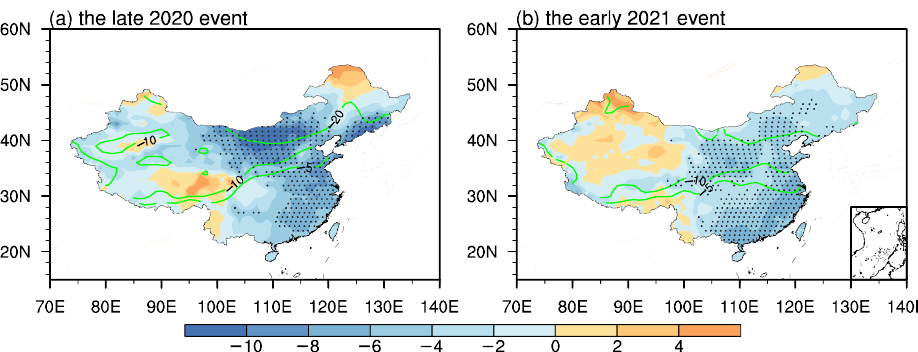
Figure 1. Average temperature drop (shading, unit: °C) in the late 2020 event and the early 2021 event. The average temperature drop is the T2m averaged during the event relative to the T2m on the day before the beginning of the event. The green contours are the minimum T2m on 29 December 2020 and 7 January 2021, respectively. Black dots indicate the starting points for the air trajectory tracking.